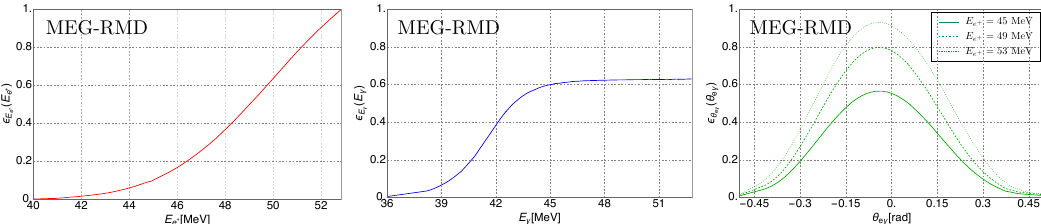
Figure 2 . Left: positron energy-dependent part (cid:15) E of the MEG trigger efficiency Middle: photon e energy-dependent part (cid:15) E of the MEG trigger efficiency. Right: polar angle-dependent part (cid:15) θ γ of the MEG trigger efficiency. The total trigger efficiency is given by eq. 2.1 up to a normalization factor c RMD = 0 . 35 , which is defined in eq. (2.4) to reproduce the number of observed RMD events N RMD | obs. = 12900 in ref.